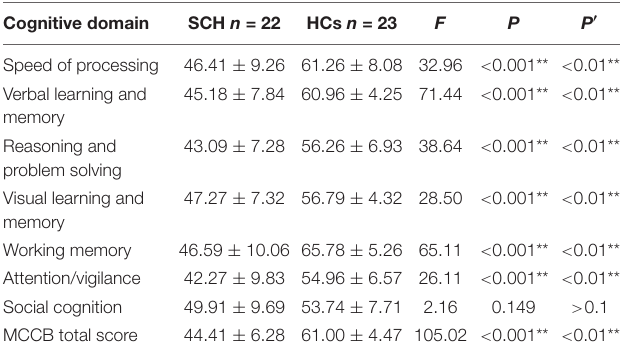
TABLE 2 | Comparison of cognitive domain between schizophrenia and